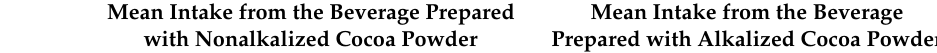
Table 2. Mean intake of energy, macronutrients, flavan-3-ols, and methylxanthines from